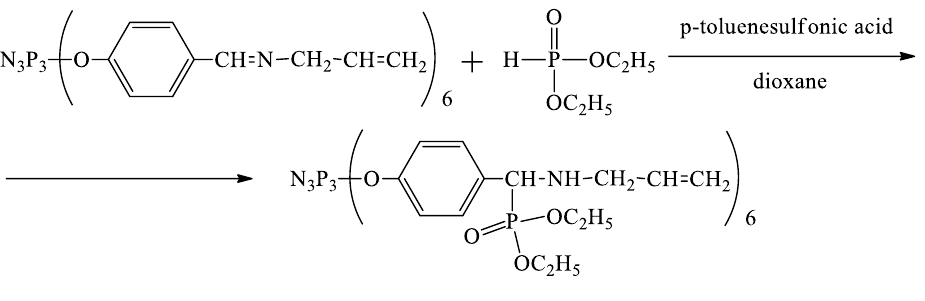
Figure 1. Scheme of extractant synthesis.